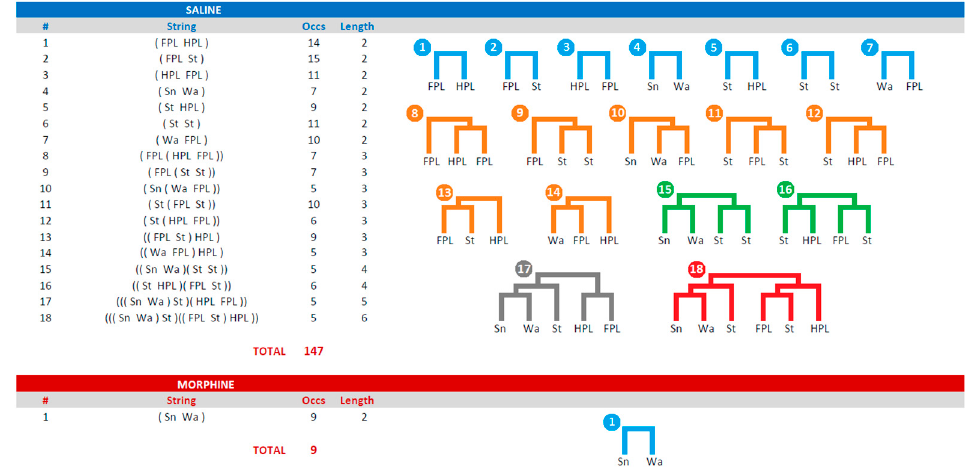
Figure 4. Results of T-pattern detection in terms of terminal strings (events in brackets) and corresponding static tree structures. Progressive numbers on the left of each string indicate the corresponding tree structure illustrated on the right side of the panel. Numbers on the right side of each string indicate overall occurrences (Occs) and length (i.e., number of events in T-pattern’s structure). For illustrative purposes, the length of each pattern is presented using different colors. Data obtained from the analysis of two groups each encompassing 10 subjects. For abbreviations, see Figure 1.